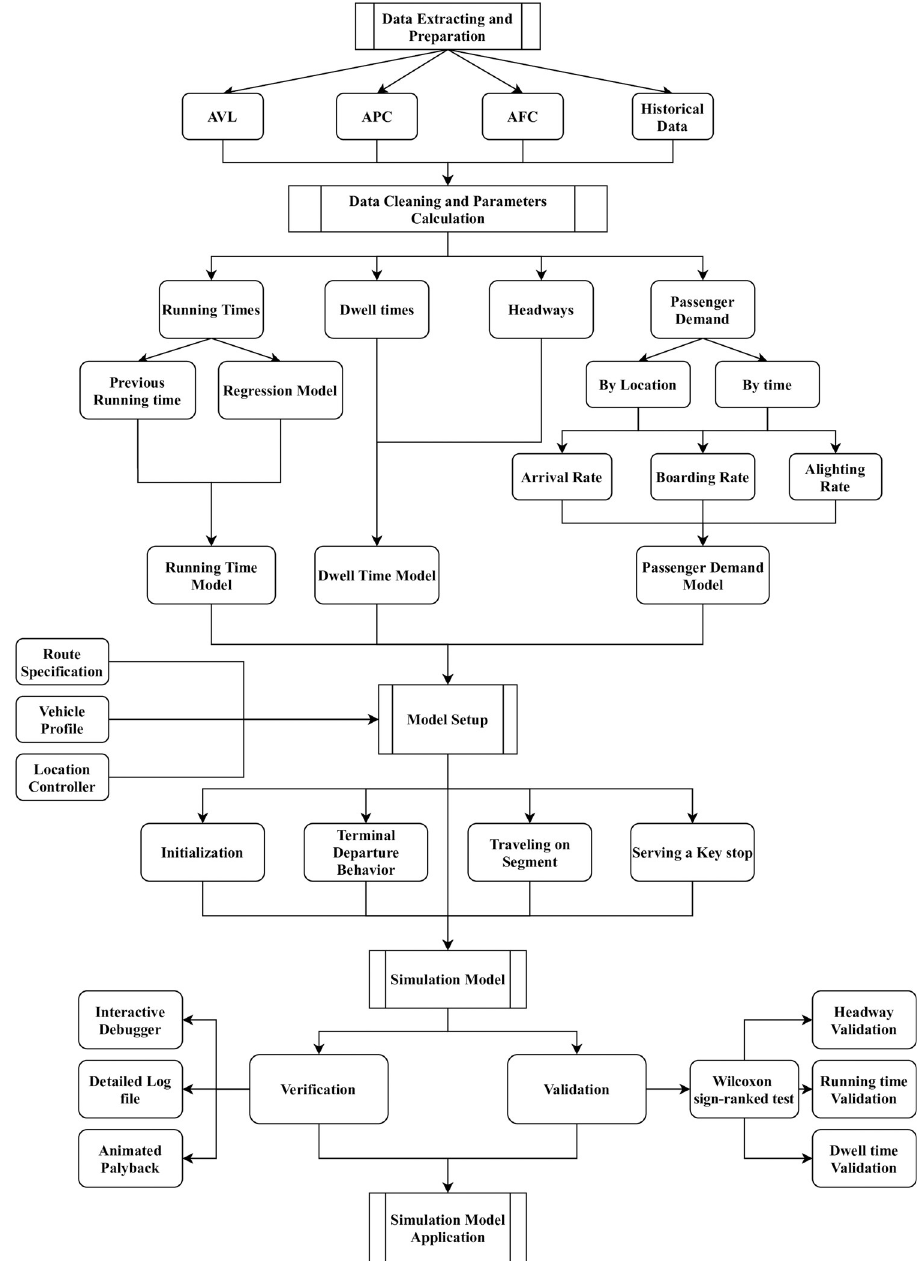
Fig 2. Simulation model activity diagram showing inputs, outputs, and high-level tasks. Route U32 was selected in order to conduct this study. This route passes across the most congested sections of the Kuala Lumpur City Centre (KLCC), providing a suitable environ- ment for conducting a study on service regularity and reliability. Route U32 is a high-fre- quency route with high passenger demand. This route has fifty-nine bus stops (almost 30 stops in each direction) and nine buses are operating along this route in an operating day. Table 2 demonstrates Route U32 specifications as well as the list of key stops in each direction.